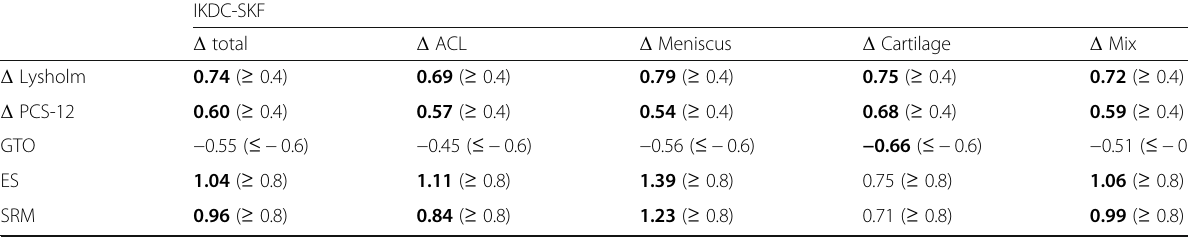
Table 4 Responsiveness of the IKDC-SKF for the total population as well as each patient subgroup